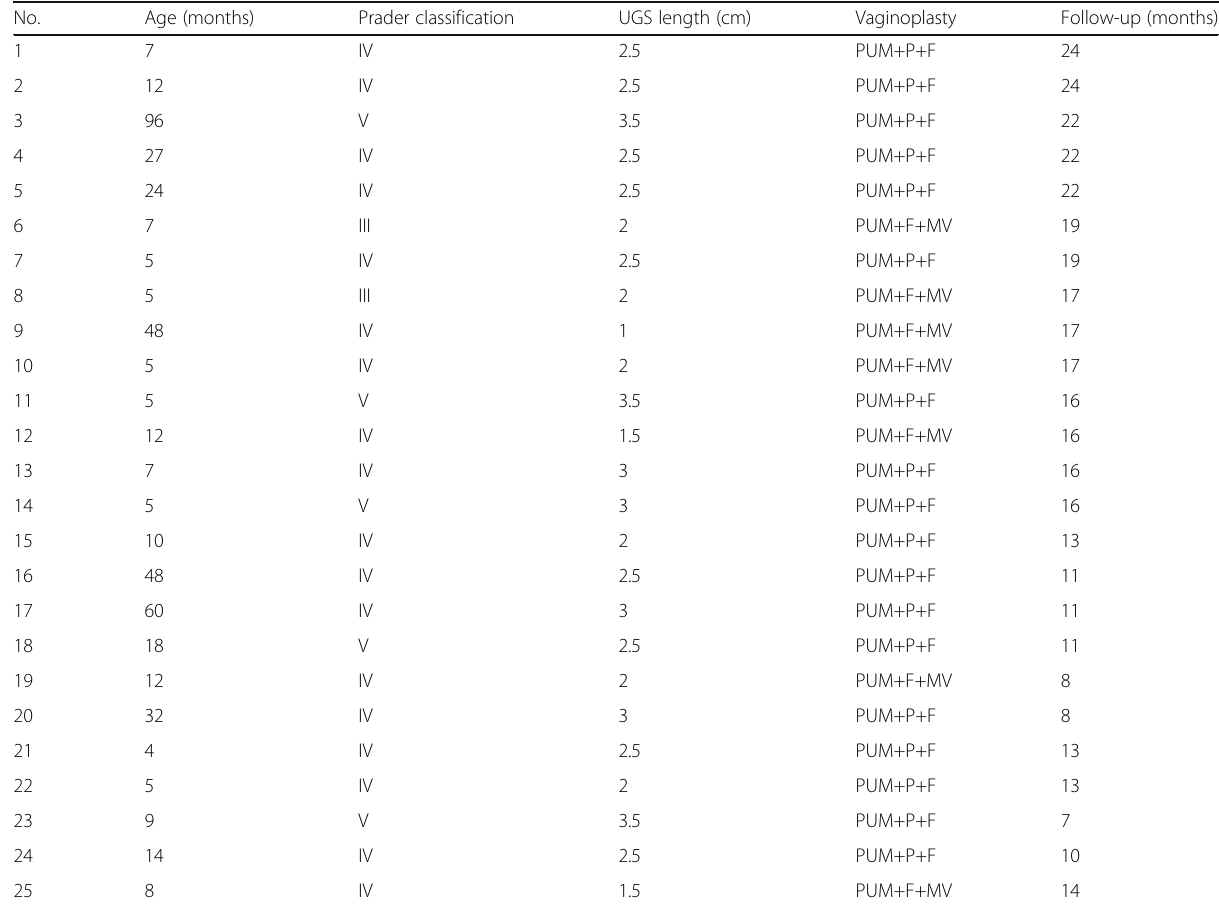
Table 1 Patients ’ characteristics and operative procedures No.